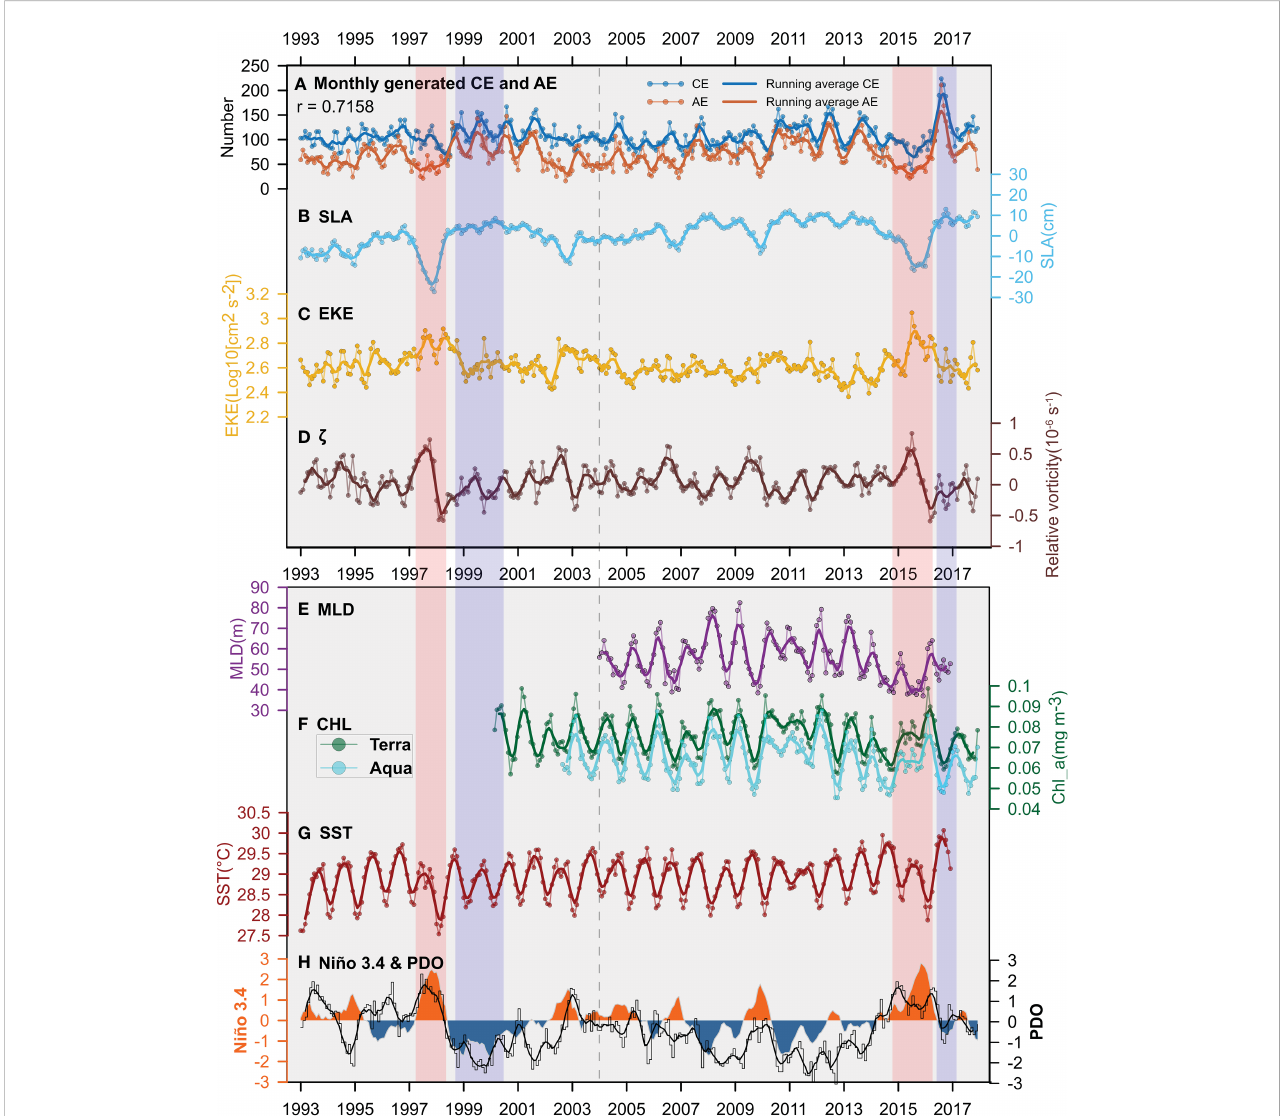
FIGURE 4 Time series of the monthly generated numbers of (A) CEs and AEs, monthly regional averaged (B) SLA, (C) EKE (log10), (D) relative vorticity ( z ) in the area of (2° – 10° N, 125° – 180° E) for the 1993 – 2017 period, and monthly regional averaged (E) Argo-derived mixed layer depth (MLD), (F) chlorophyll-a (CHL) concentration, (G) sea surface temperature (SST) in the area of (0° – 15° N, 125° – 180° E), and (H) Niño 3.4 and PDO indices. The dotted lines in (A – G) show the original data and the bold lines indicate 5-step moving-averaged data. The color patches in (H) represent the Niño 3.4 index, while the black lines represent the PDO index with the thin black and thick black lines indicating the original data and 5-step moving-averaged data, respectively. The red and blue shaded areas indicate two strong El Niño and La Niña phases,